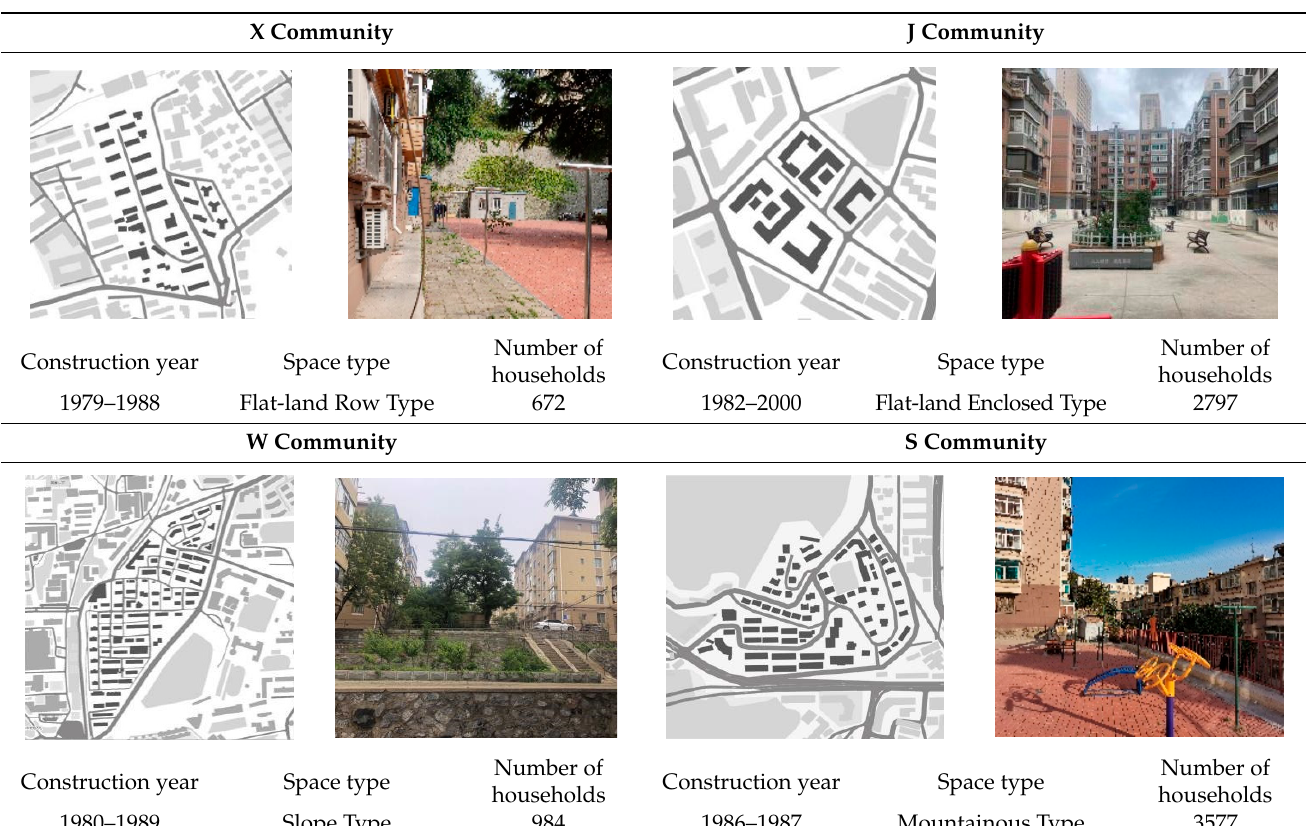
Table 1. Four types of typical residential areas in Dalian.